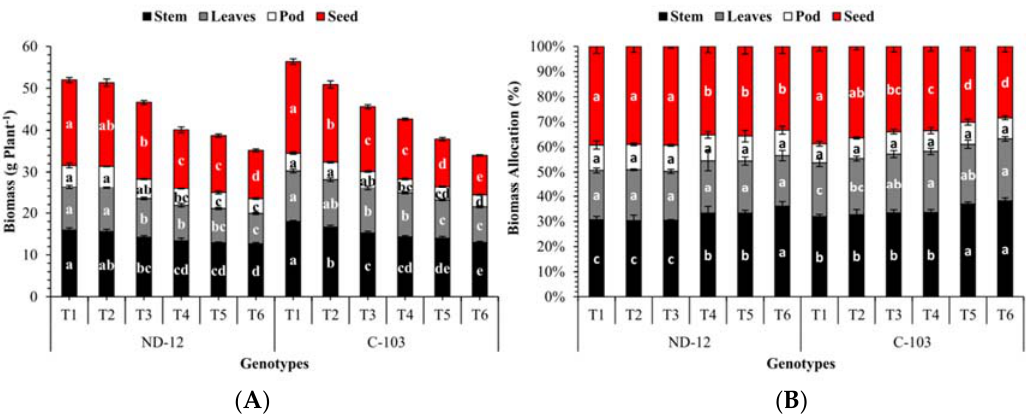
Figure 4. Biomass of different plant parts (stem, leave, pod and seed) ( A ) and biomass allocation (Percentage of total plant mass) ( B ) for the different plant parts. T1, 100/100; T2, 100/50; T3, 100/20; T4, 50/50; T5, 50/20; T6, 20/20.